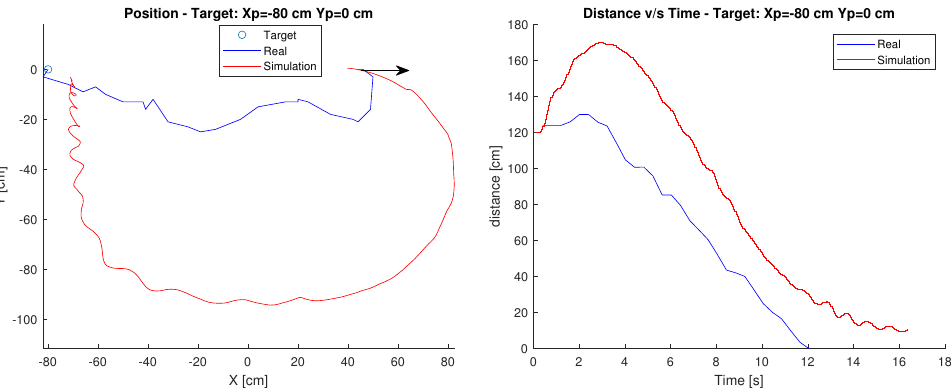
Figure 10. Position and distance to target X p = − 80 cm, Y p = 0 cm with the IPC